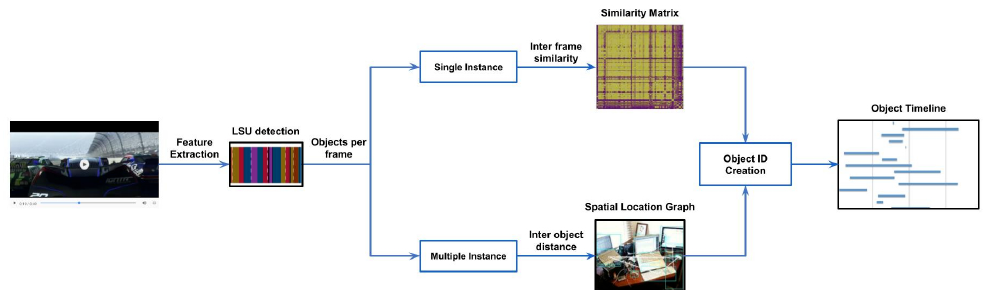
Figure 11. Proposed pipeline for multi-object re-ID. Given the input video, we estimate LSU and objects per frame for the video. Based on the number of occurrences of the object in a frame, the objects are categorised as single- and multi-instance objects. Subsequently using the inter-frame similarity and graph-based algorithms, object IDs are created and